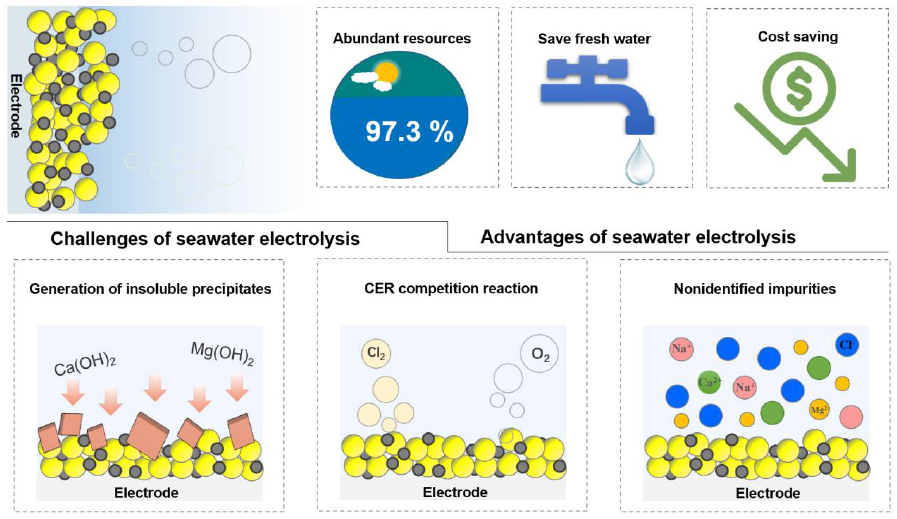
Figure 1. Advantages and challenges of seawater electrolysis.